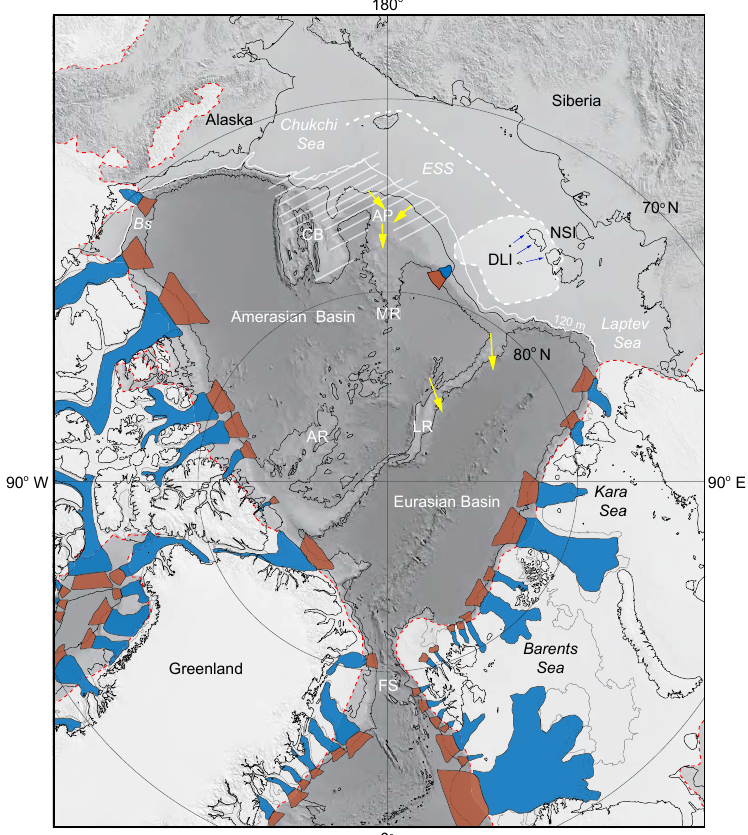
Figure 1. Map of the Arctic Ocean showing the maximum extent of Quaternary glaciations (red dashed line) (Jakobsson et al., 2014). The 120m isobath is highlighted across the Siberian, Chukchi and Beaufort seas to highlight the potential extent of exposed land during the global eustatic low stand of the LGM. Yellow arrows indicate the direction of ice flow inferred from the orientation of glacial landforms on the deep Arctic seafloor (Jakobsson et al., 2016). Glacial extents and flow directions around the New Siberian Islands (NSI) and De Long Islands (DLI) are redrawn from Basilyan et al. (2008). Dashed lines across the East Siberian shelf and hatching on the Chukchi Borderland (CB) indicate areas of probable glacial ice in the late Quaternary (Jakobsson et al., 2014). Known glacially excavated cross-shelf troughs (blue) and trough mouth fans (brown) are redrawn from Batchelor and Dowdeswell (2014) – the exception is the single trough on the East Siberian shelf, which is described in this paper. AP – Arlis Plateau; AR – Alpha Ridge; BS – Beaufort Sea; FS – Fram Strait; MR – Mendeleev Ridge; LR – Lomonosov